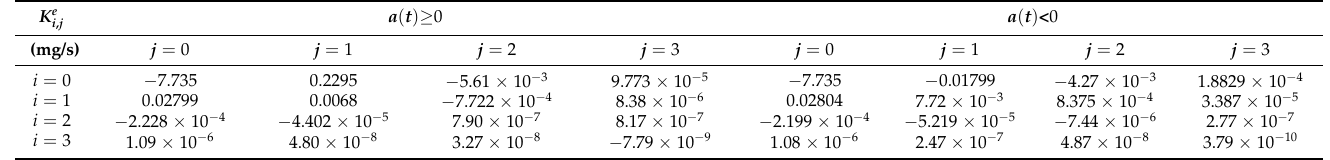
Figure 8. The procedure of the improved MPC strategy. Table 2. The emission coefficients for the MOE of carbon dioxide [30].